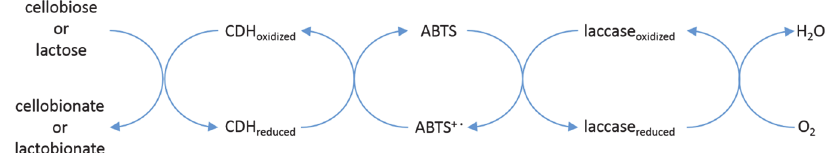
Fig 1. Enzymatic oxidation of substrate (cellobiose/lactose) by CDH. The reduced CDH is oxidized by a redox mediator (ABTS), which is in turn oxidized by laccase. The reduced laccase is oxidized by oxygen, with water as the only